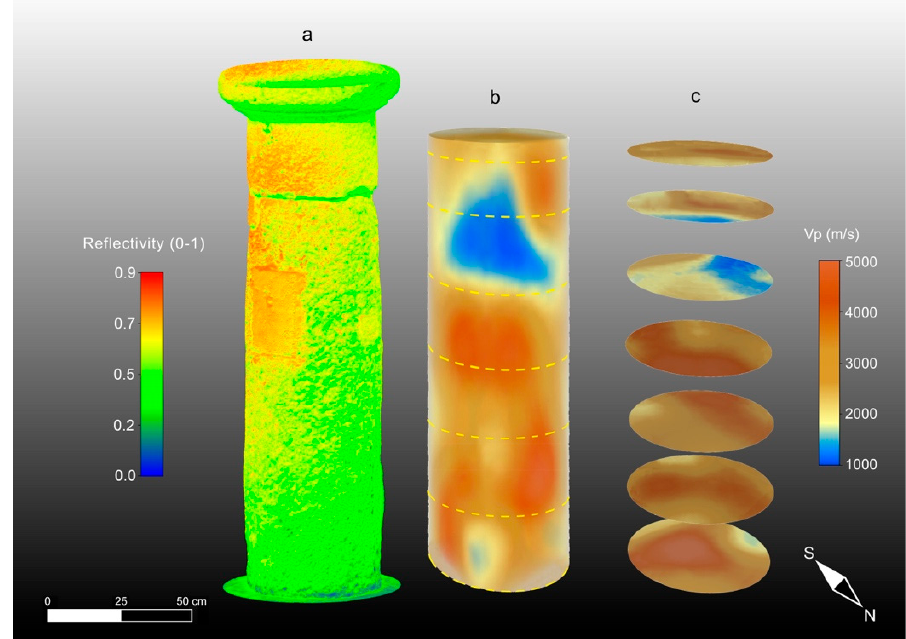
Figure 14. High-resolution 3D models of column 1. ( a ) TLS reflectivity model; ( b ) ultrasonic tomog- raphy; ( c ) tomographic slices.